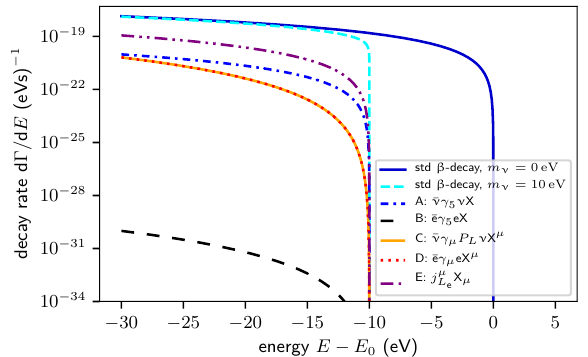
Figure 4 . Differential spectrum. Shown are 7 different cases: standard b -decay without (solid blue) and, for comparison, with 10 eV (dashed cyan) neutrino mass, as well as the 5 spectra as expected for the additional emittance of a light boson X with g X = 1 , m X = 10 eV with type according to table 1. (Legend: dash dotted blue — A, dashed black — B, solid orange/dotted red — C/D, dashed double-dotted violet —